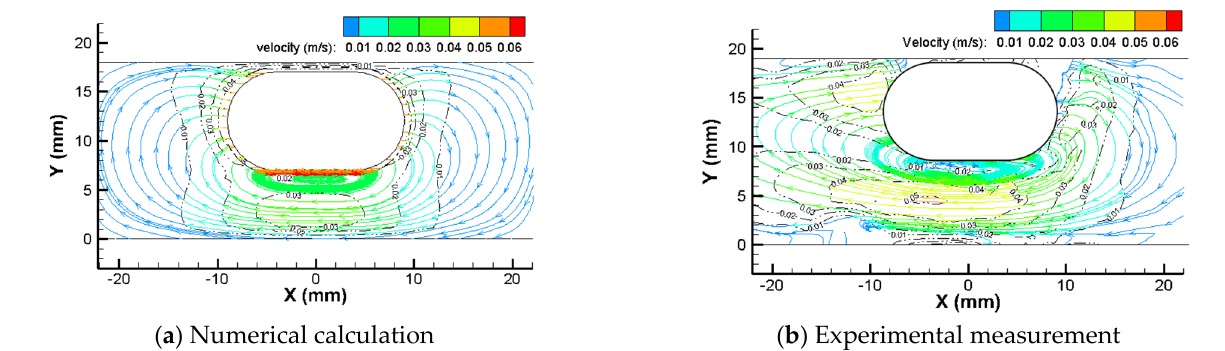
Figure 9. Streamlines and velocity of fluid around the capsule robot ( d = 18 mm, v = 0.05 m/s, n = 60 r/min, and η = 0.02 Pa·s).